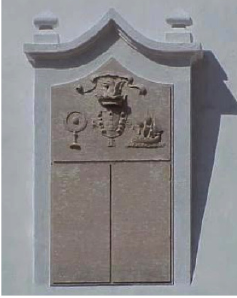
FIGURE 1 | M.Simões, School of Sagres , 1840, bas-relief, marble, Sagres Fortress,